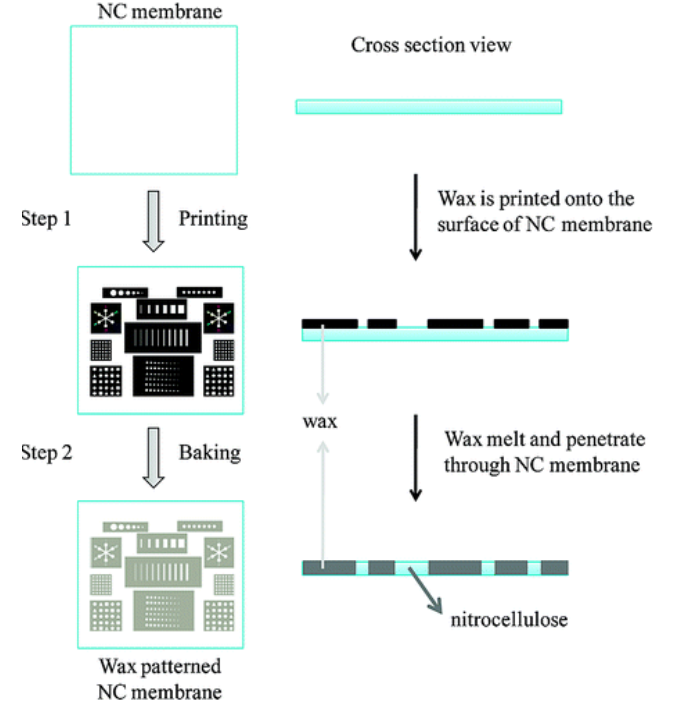
Figure 2. Schematic diagram of printing wax onto a nitrocellulose (NC) membrane.